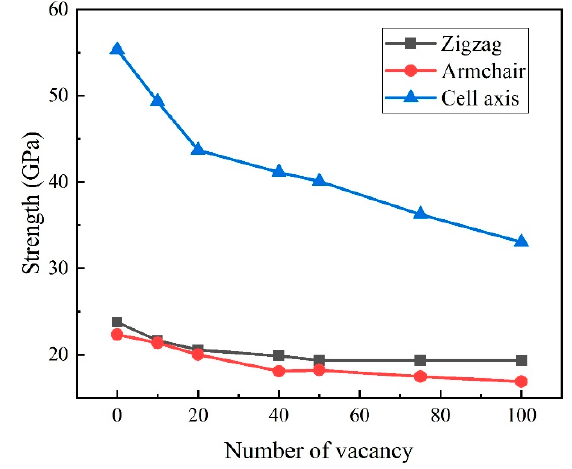
Figure 7. The effect on vacancy concentration on the mechanical strength of CHC for tensile loading along zigzag, armchair and cell axis direction, respectively.